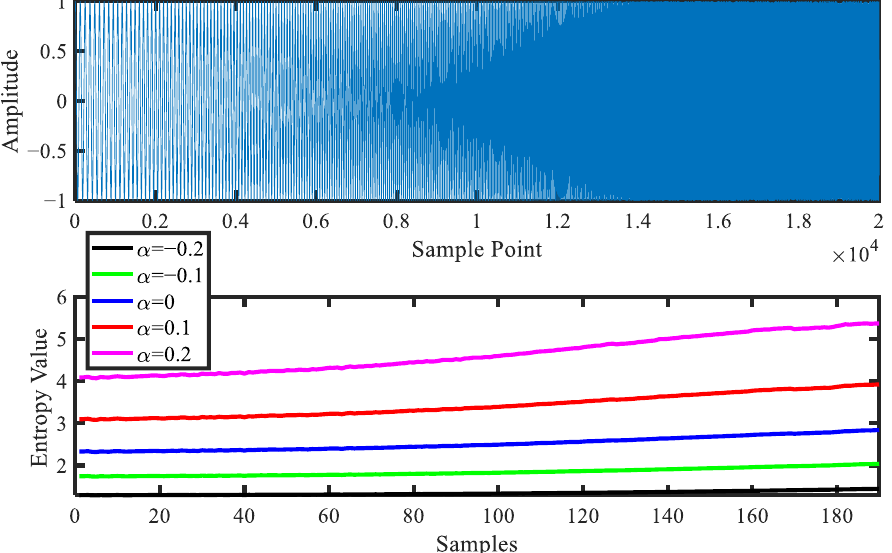
Figure 6. Chirp signal ( top ) and the corresponding different entropy curves ( bottom ).